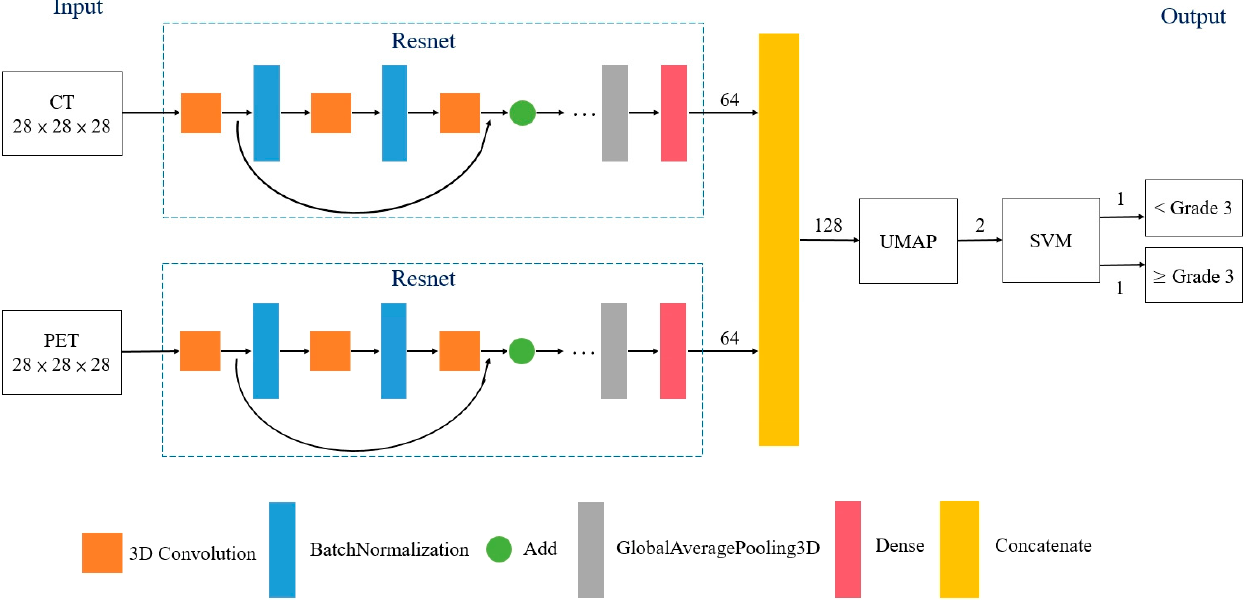
Figure 1. Structure of proposed model for classifying favorable responses to neoadjuvant chemoradiotherapy in patients with rectal cancer. Triplet loss for Resnet was utilized as a loss function for the ML algorithms. Abbreviations: UMAP = Uniform Manifold Approximation and Projection; SVM = support vector machine.